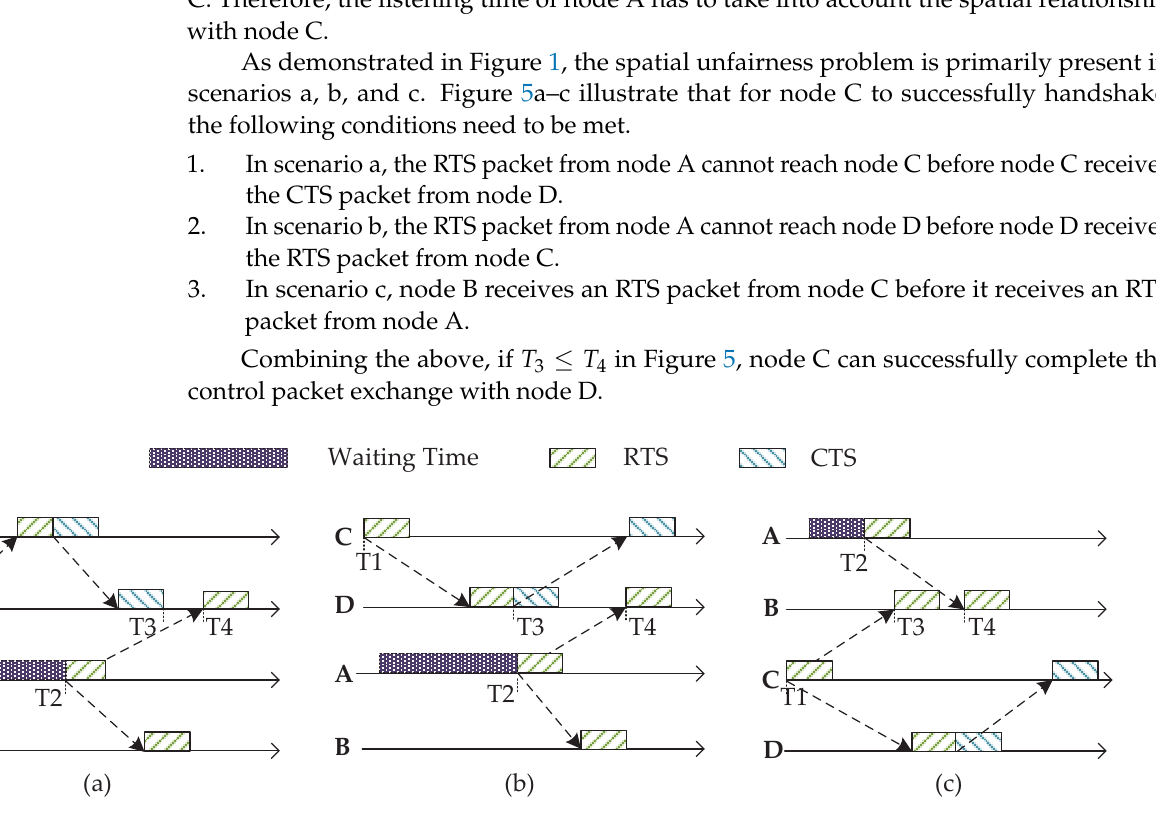
Figure 5. Timing diagram of spatial unfairness scenario with the spatial fairness waiting time. ( a ) The exposed transmit terminal. ( b ) The exposed receive terminal. ( c ) The hidden transmit terminal. The T 3 ≤ T 4 is converted into the relationship between T 1 , T 2 , propagation delay and packet duration as